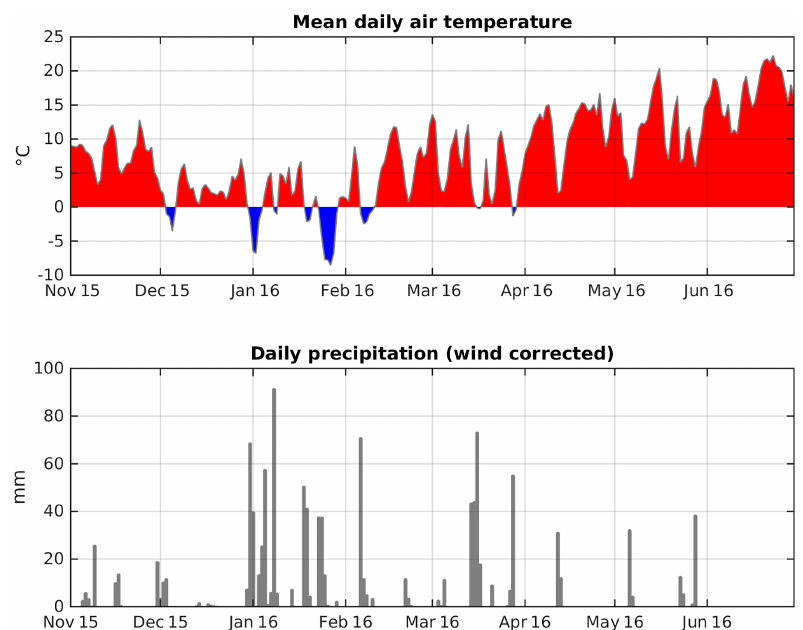
Figure 4. Example of daily precipitation and temperature observations at Laqlouq (1840ma.s.l.) during snow season 2015–2016 (November–June).